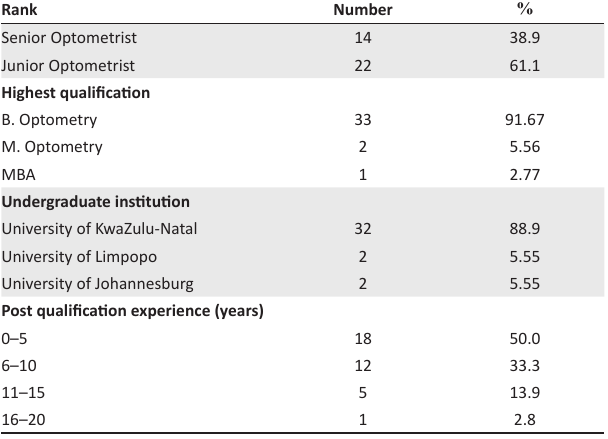
FIGURE 1: Equipment available to diagnose and manage keratoconus.